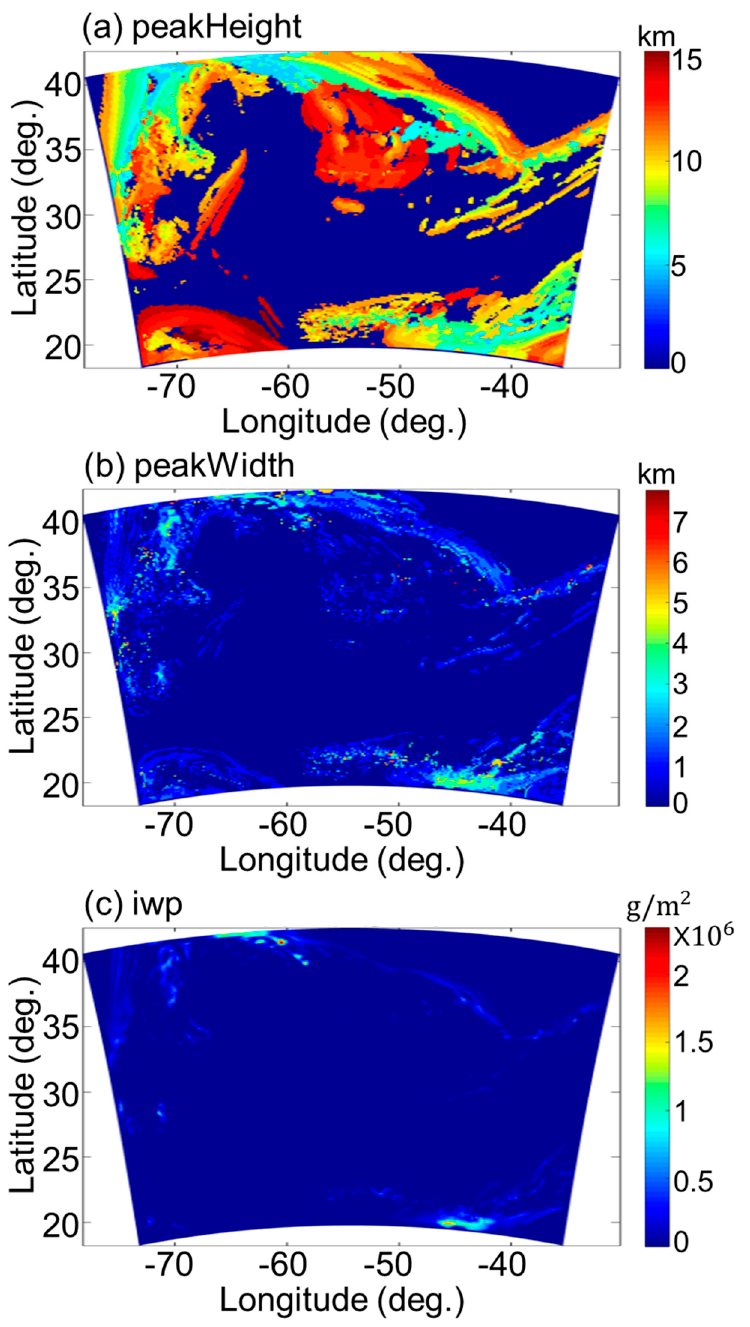
Figure 3. Maps of: ( a , b ) cloud mixing ratio peak height and width; and ( c ) IWP on 3 October 2016, at 1200 UTC. These are the three critical elements used to cluster the atmospheric state in a certain domain .